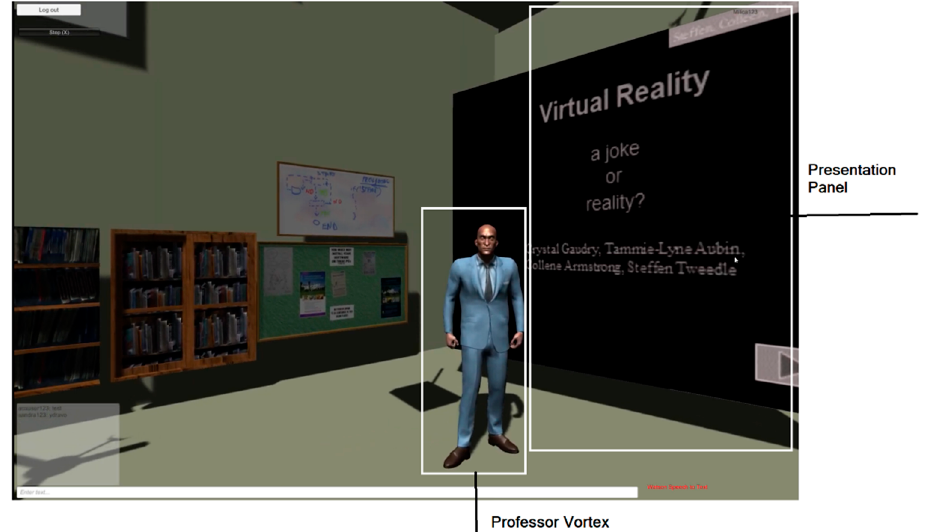
Figure 6. VoRtex virtual environment (Windows desktop, first-person perspective).